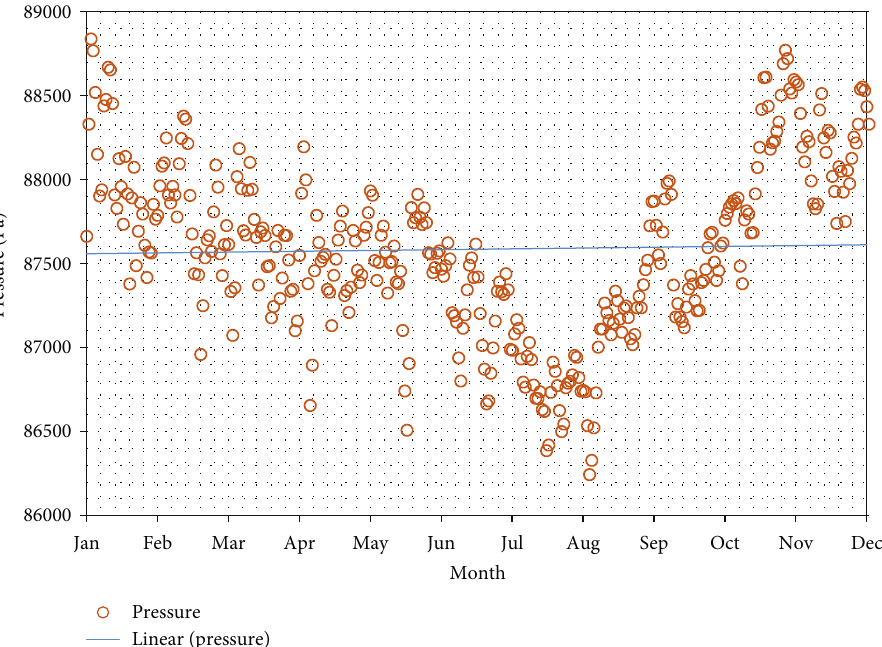
Figure 5: Monthly atmospheric pressure around the modeled